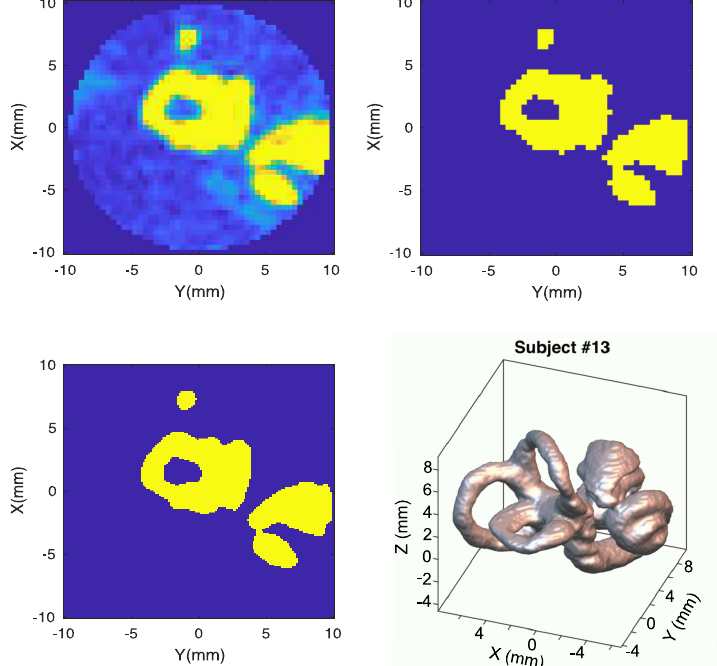
Figure 2. ( Top left ) original section from the MRI scan; ( Top right ) binarization using the same resolution; ( Bottom left ) binarization upscaling the original matrix; and ( Bottom right ) isovolume obtained using the upscaled